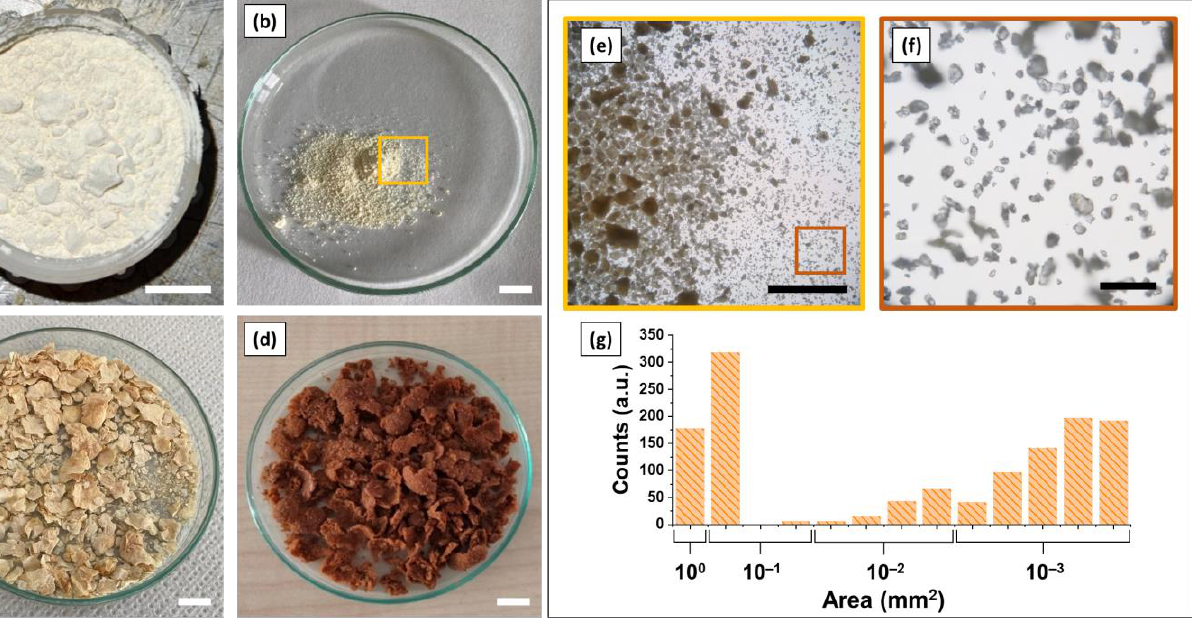
Figure 1. ( a ) FD_CNC1, ( b ) FD_CNC2 and ( c ) SE_CNC1 and ( d ) SE_CNC2. Scale bar is 1 cm for all pictures. ( e ) 2× and ( f ) 20× magnification of FD_CNC2, acquired with optical microscope. Scale bars are equal to 1 mm and 100 μm, respectively. ( g ) Average particle size distribution of modified CNCs.